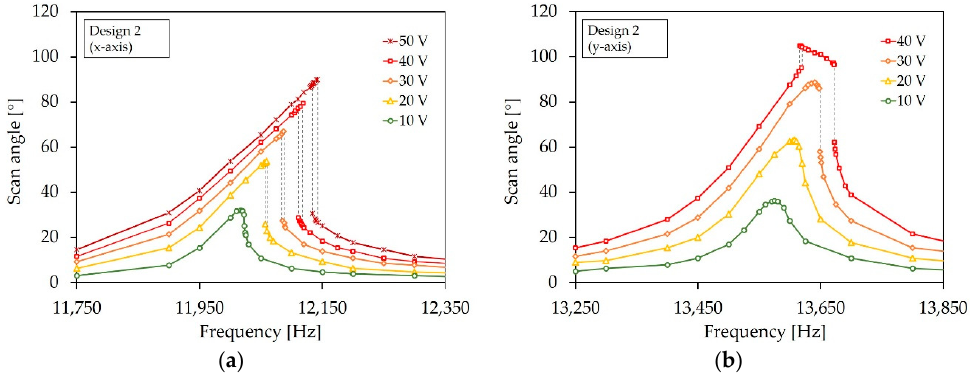
Figure 25. Frequency response curves of Design 2: ( a ) x-axis; ( b ) y-axis.